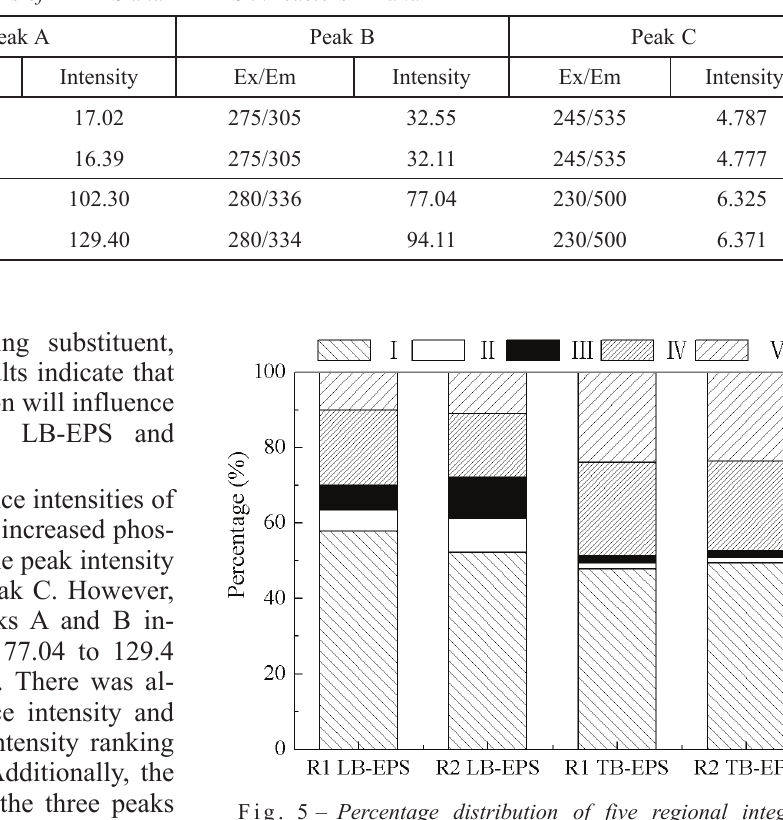
Fig. 5 – Percentage distribution of five regional integral standard volumes of LB-EPS and TB-EPS in